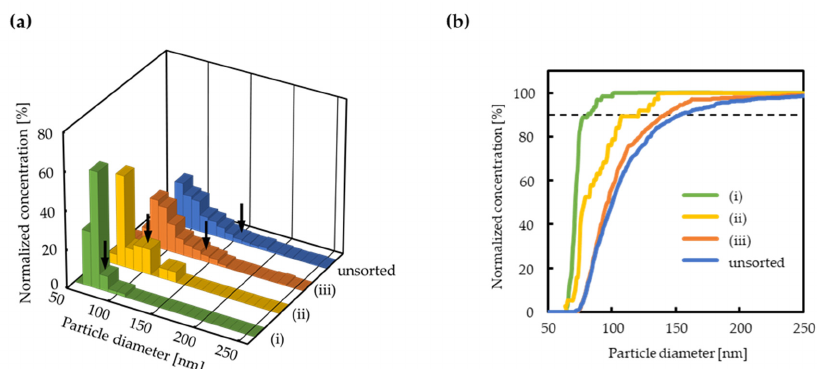
Figure 5. Results of the size sorting of exosomes. ( a ) Distribution of exosome sizes before and after sorting. The black arrows indicate d 90 in each distribution. ( b ) Cumulative distribution of exosome size. Black dashed line: d 90 . The concentrations of the running buffer under (i)–(iii) are the same as those in Figure 4. Figure Table 2. d 90 and d max values in the collected exosomes, and λ Gate,cal and λ Gate,exp values under each condition.